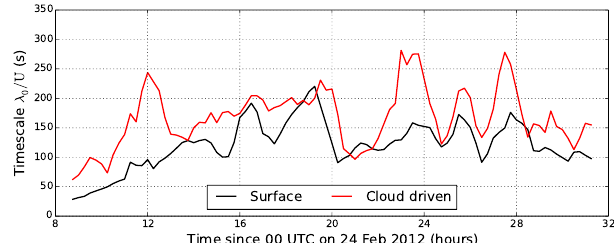
Figure 9. Advective timescales corresponding to the largest scales within the inertial subrange ( λ 0 ) shown in Fig. 8 from the surface- based (black) and cloud-driven layers (red). U denotes the horizon- tal wind